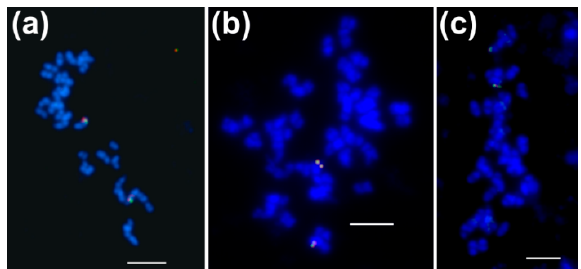
Figure 1. Localization of BAC-based chromosome-specific markers in the L. angustifolius genome. Chromosomes were counterstained with DAPI (blue). BACs were labeled with digoxigenin-11-dUTP (green signals) and tetramethylrhodamine-5-dUTP (red signals); ( a ) 009a01 (green) and 126d14 (red) ( accC sub-library, NLL-06); ( b ) 046i04 (green) and 060f02 (red) ( accA sub-library, NLL-11); ( c ) 080b11 (green) and 009a01 (red) (NLL-06). Scale bar = 5 μ m.